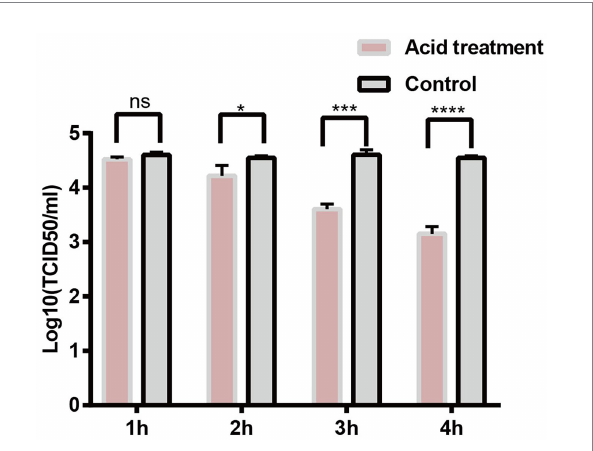
FIGURE 6 PCV2 tolerates environmental pH 2.0. PK15 cells were inoculated with PCV2d-LNHC at pH 2.0 and incubated for 1–4 h at 37 ° C. The viral titers in the acid-treated PCV2-infected and mock-PCV2- infected cells were determined with virus